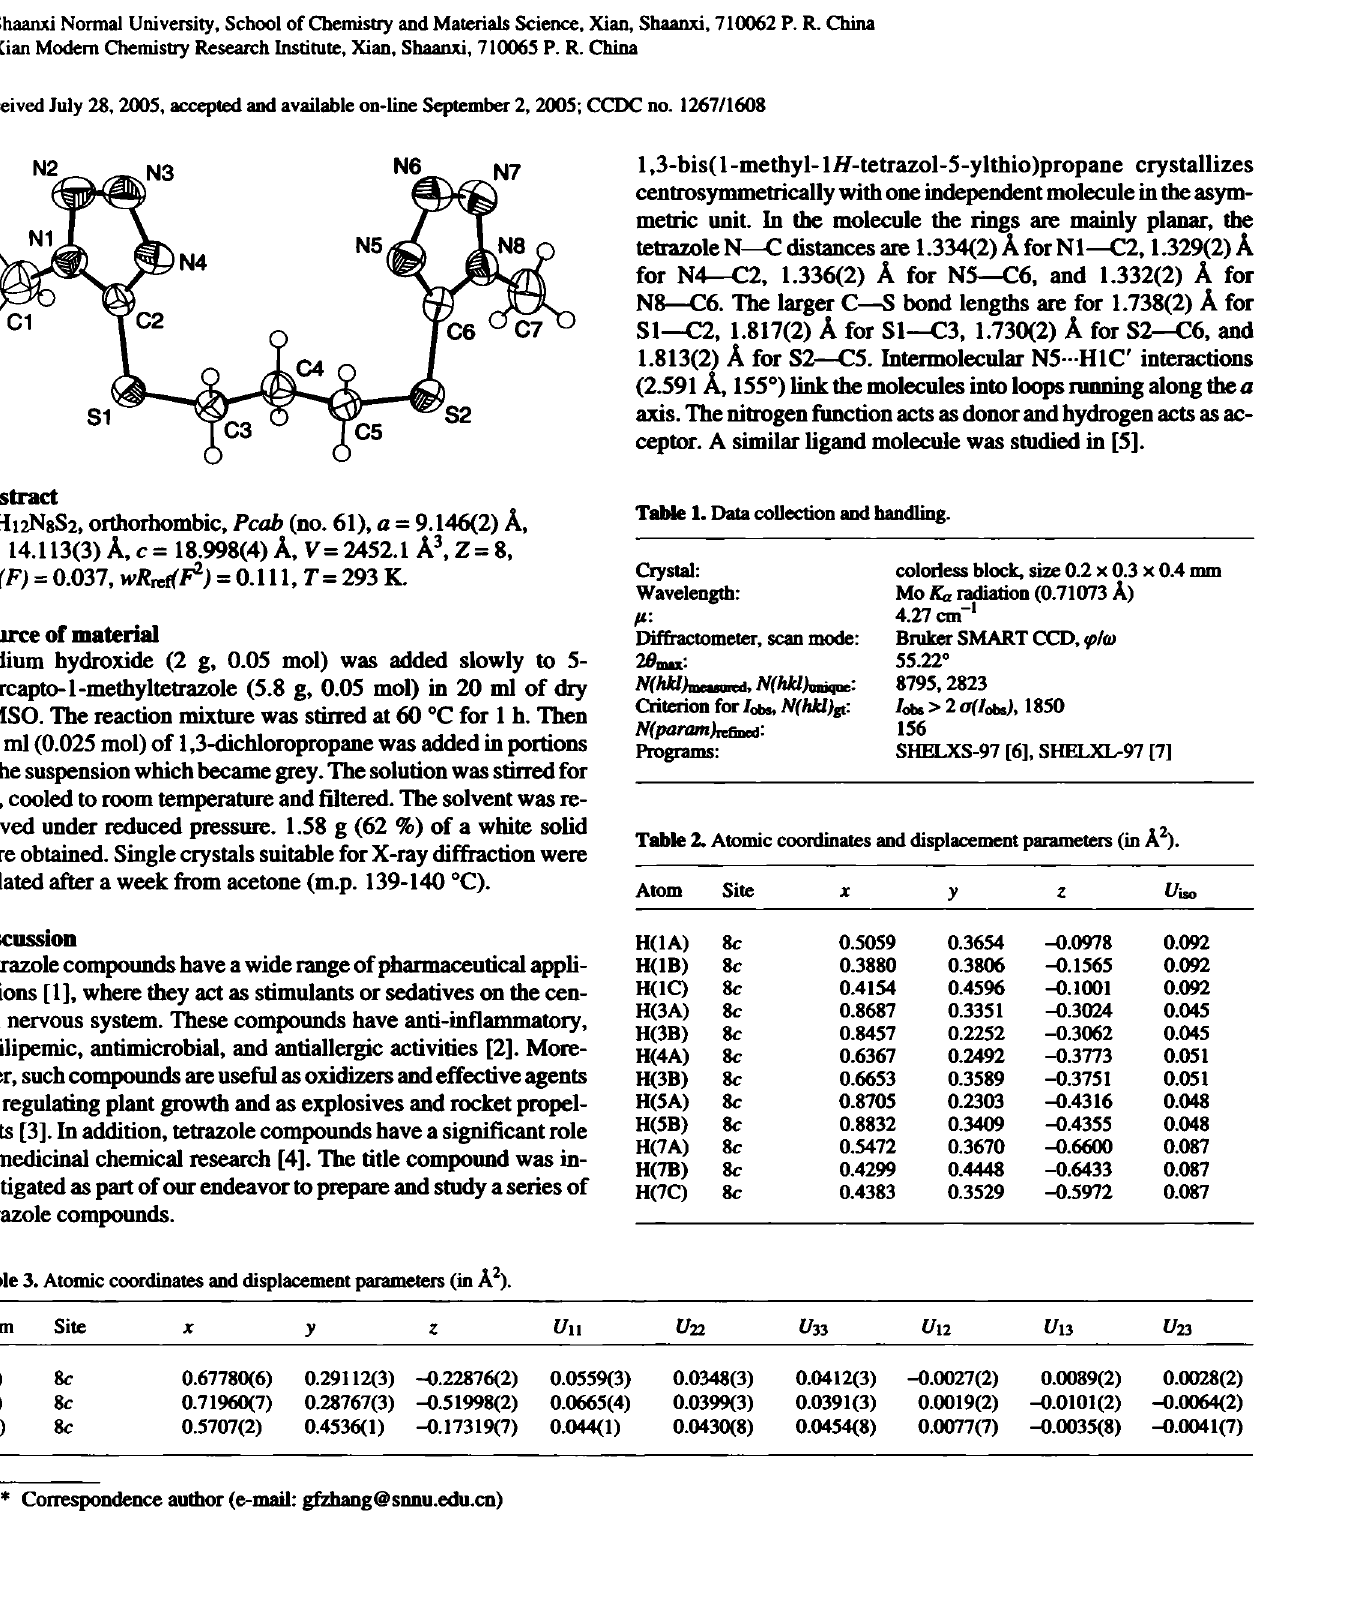
Table 3. Atomic coordinates and displacement parameters (in A 2 ).